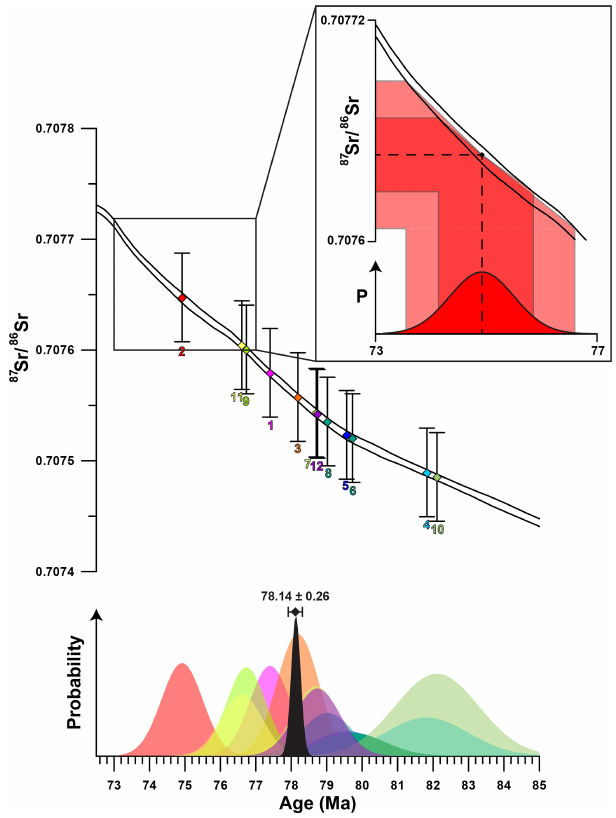
Figure 4. Plot showing the results of Sr-isotopic analyses with error bars (2 σ ) plotted on the Sr-isotope curve of McArthur et al. (2016; top of image). Numbers below the error bars indicate specimen number. Measurements from the 12 specimens of R. diluvianum are represented by parallelograms in different colors which match the probability distributions plotted below. The probability distribution curves in the lower panel show the distribution of uncertainty of each Sr-isotope measurement as well as the uncertainty of the Sr- isotope curve propagated to the age domain (colors of individual shells are the same as in Fig. 2). Inset shows schematically how un- certainties of the isotope measurements as well as the isotope curve are propagated into the age domain. The black curve shows the to- tal uncertainty distribution function compiled from the 12 individ- ual measurements following Barlow (2004), with the combined age estimate including uncertainty (2 σ ) shown